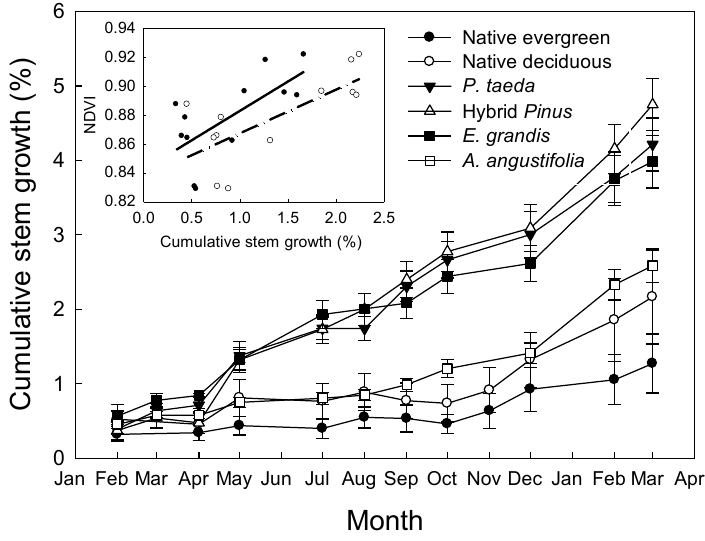
Figure 6. Cumulative stem diameter changes (percentage growth normalized to the initial stem diameter) for deciduous and evergreen trees in the native forest and four tree plantations from February 2012 to March 2013. Vertical bars in March 2013 indicate the SE. The inset indicates the significant relationship ( p < 0.05) between NDVI and the cumulative stem growth of native evergreen species (black circles and solid line, R 2 = 0.42) and the native deciduous species (white circles and dash-dot line, R 2 =